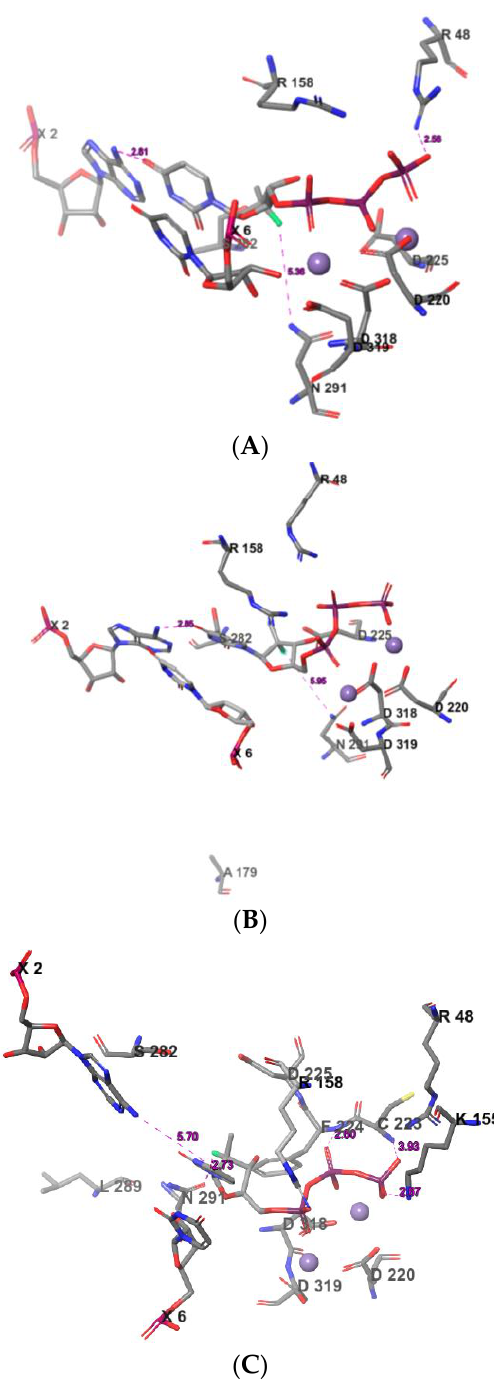
Figure 5. The active site conformation of WT ( A ), T179A ( B ), and M289L ( C ) systems taken from most populated cluster.